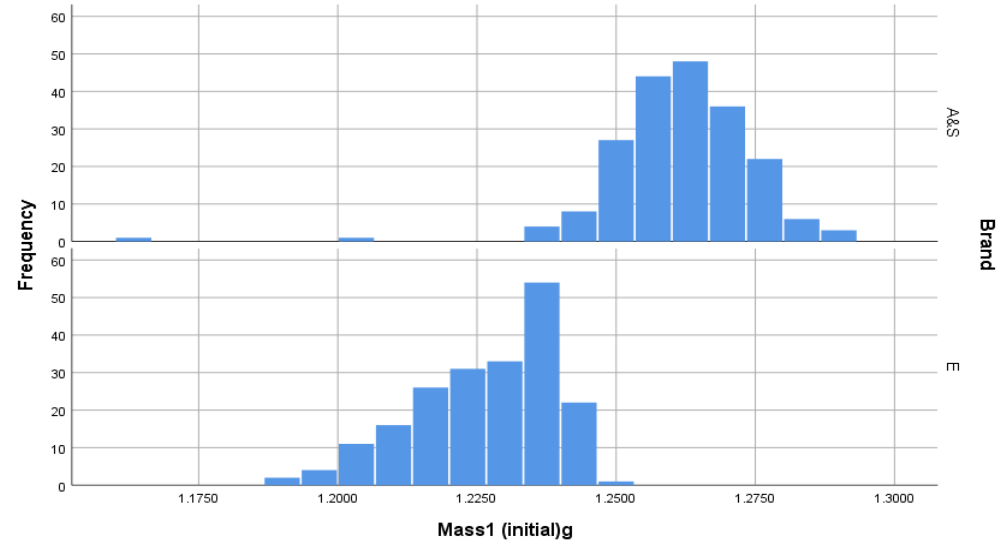
Figure 10. Initial mass of unfired cartridges illustrating that AS-head-stamped cartridges were heavier than E-head-stamped cartridges.